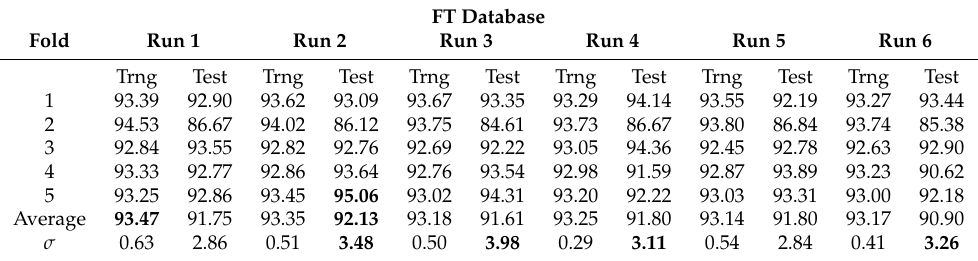
Table 9. Performance of the best individuals of the GBVSBP + MCG model for all FT database runs. Each pair of training and testing corresponds to one experiment of the k-fold. Therefore, we obtain 30 executions of our system and report the standard deviation for each run set.